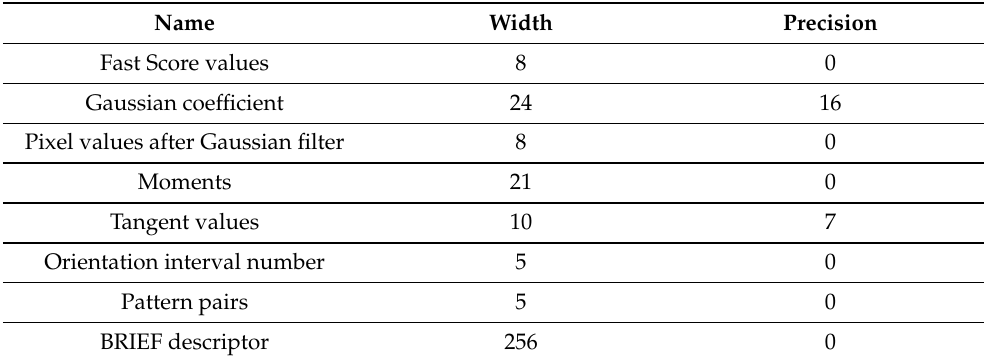
Table 1. Fixed-point precision applied at different stages of the ORB